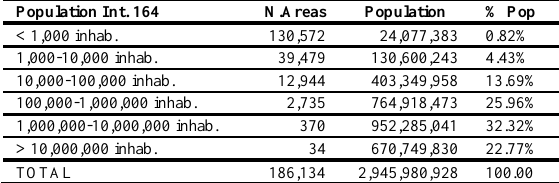
Table 2. Population distribution of the AHIL (intensity